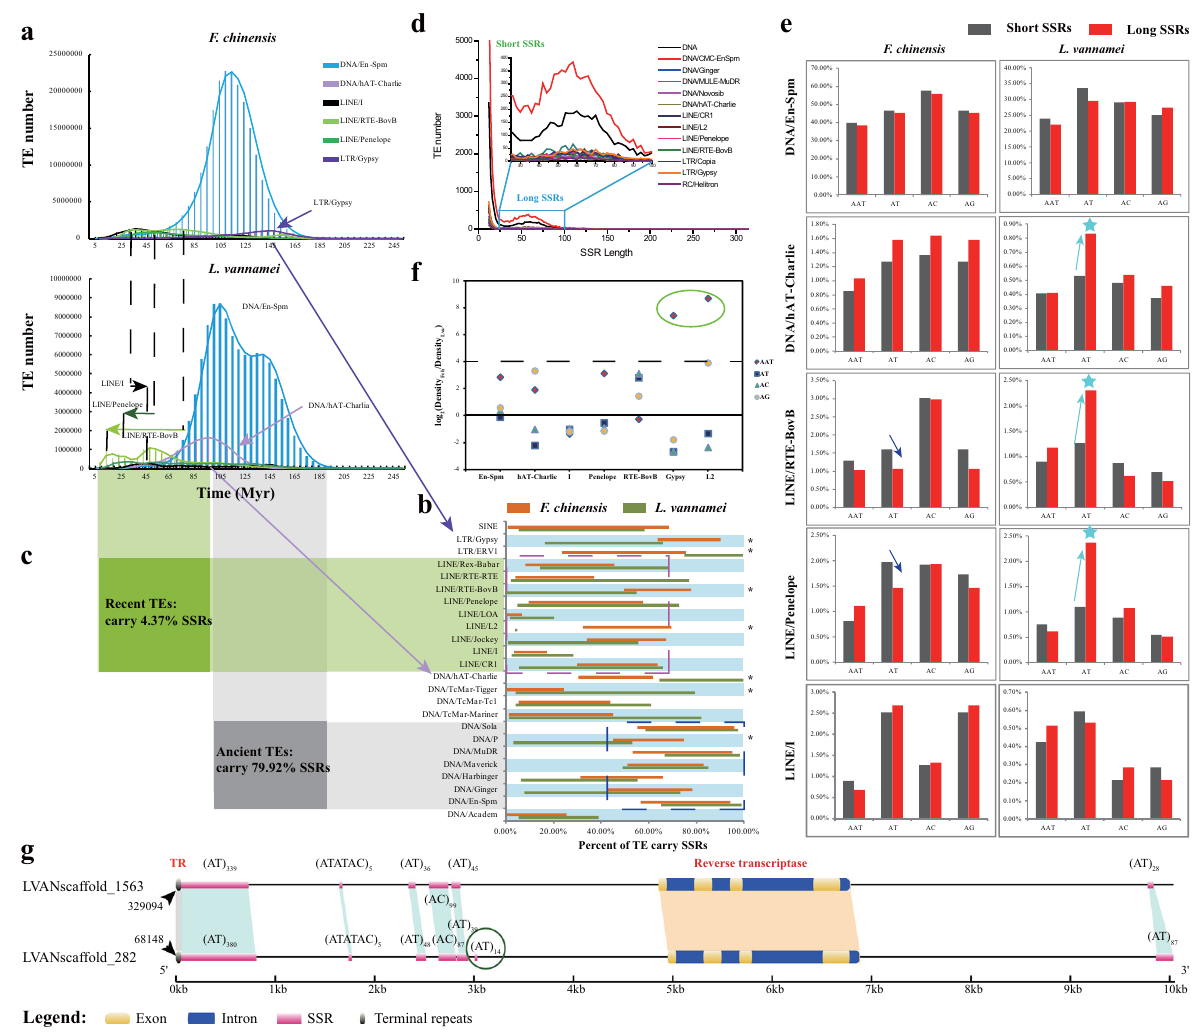
Fig. 2 Relationship between TEs and SSR expansion. a Age distribution of major expanded TEs in the two penaeid shrimp genomes. According to previous studies 57 , the substitution rate of decapods is 2 × 10 − 9 substitutions per site per year. b Percentage of TEs harboring SSRs in the two shrimp genomes. The SSRs located within TEs (hide bar) and 100 bp up- and downstream of TEs (orange and green bars) were counted separately. *Indicates signi fi cant difference ( p < 0.05) of the TEs harboring SSRs between L. vannamei and F. chinensis . c Comparison of ancient and recent TEs that carrying SSRs. d Distribution of the number of TEs containing variable lengths of SSRs. Two peaks representing short and long SSRs were identi fi ed in the curve plot. e Comparison of TEs containg short and long SSRs. The stars indicate the signi fi cant differences with p < 0.05. The short and long SSRs were selected according to a curve plot of the numbers of TEs with different SSR lengths (Supplementary Fig. 19). Since a single peak (representing short SSRs) was observed in the length distribution of (AAT) n , long (AAT) n SSRs were considered those with lengths longer than 35 bp. f Comparison of SSR density in various TEs of F. chinensis and L. vannamei . A positive value of log 2 (Density Fch /Density Lva ) indicates that the SSR density in correspondent TE was higher in F. chinensis than L. vannamei , and verse versa. g Synteny of recently transposed TEs (Penelope). SSR elongations and new insertions (green circle) were identi fi ed in the transposed